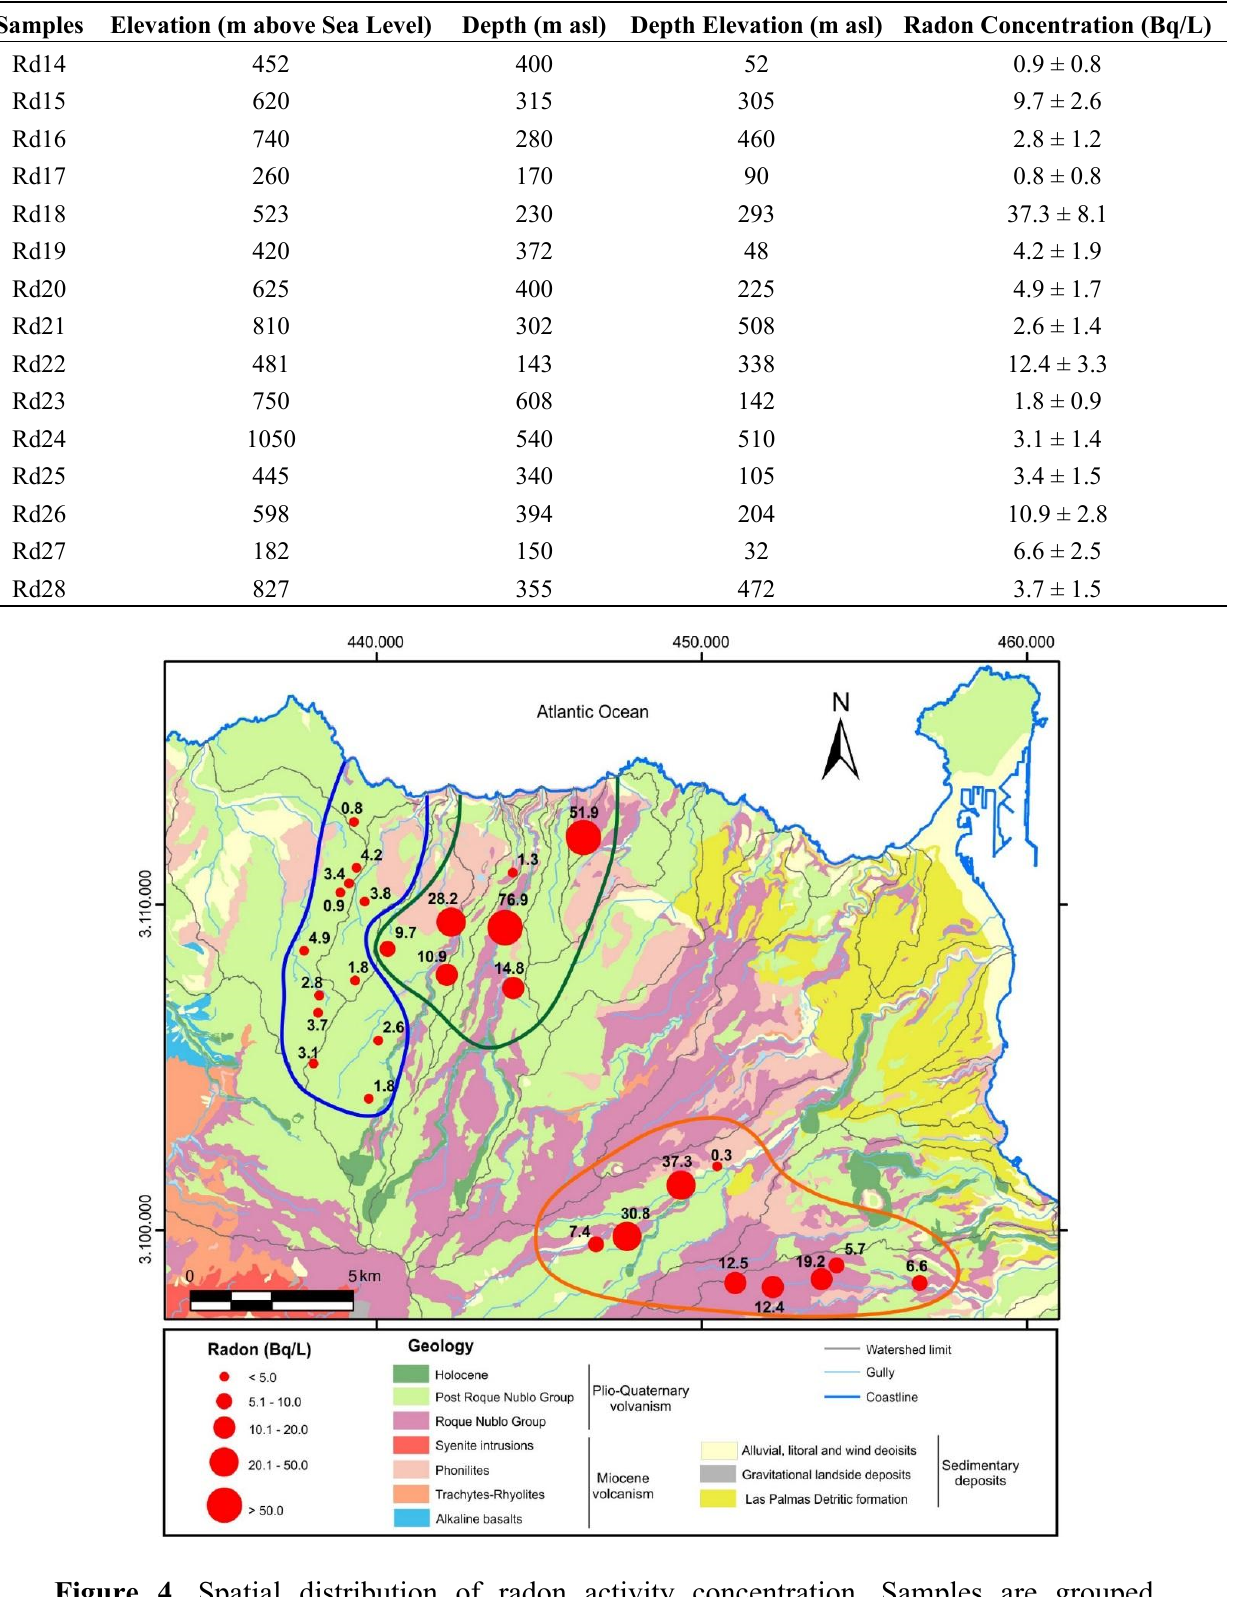
Figure 4. Spatial distribution of radon activity concentration. Samples are grouped depending on concentration of radon and geographic distribution. The blue group is located in the Guia-Moya basins, the green group in the Moya-Azuaje basins, and the orange group in the Guiniguada-Telde